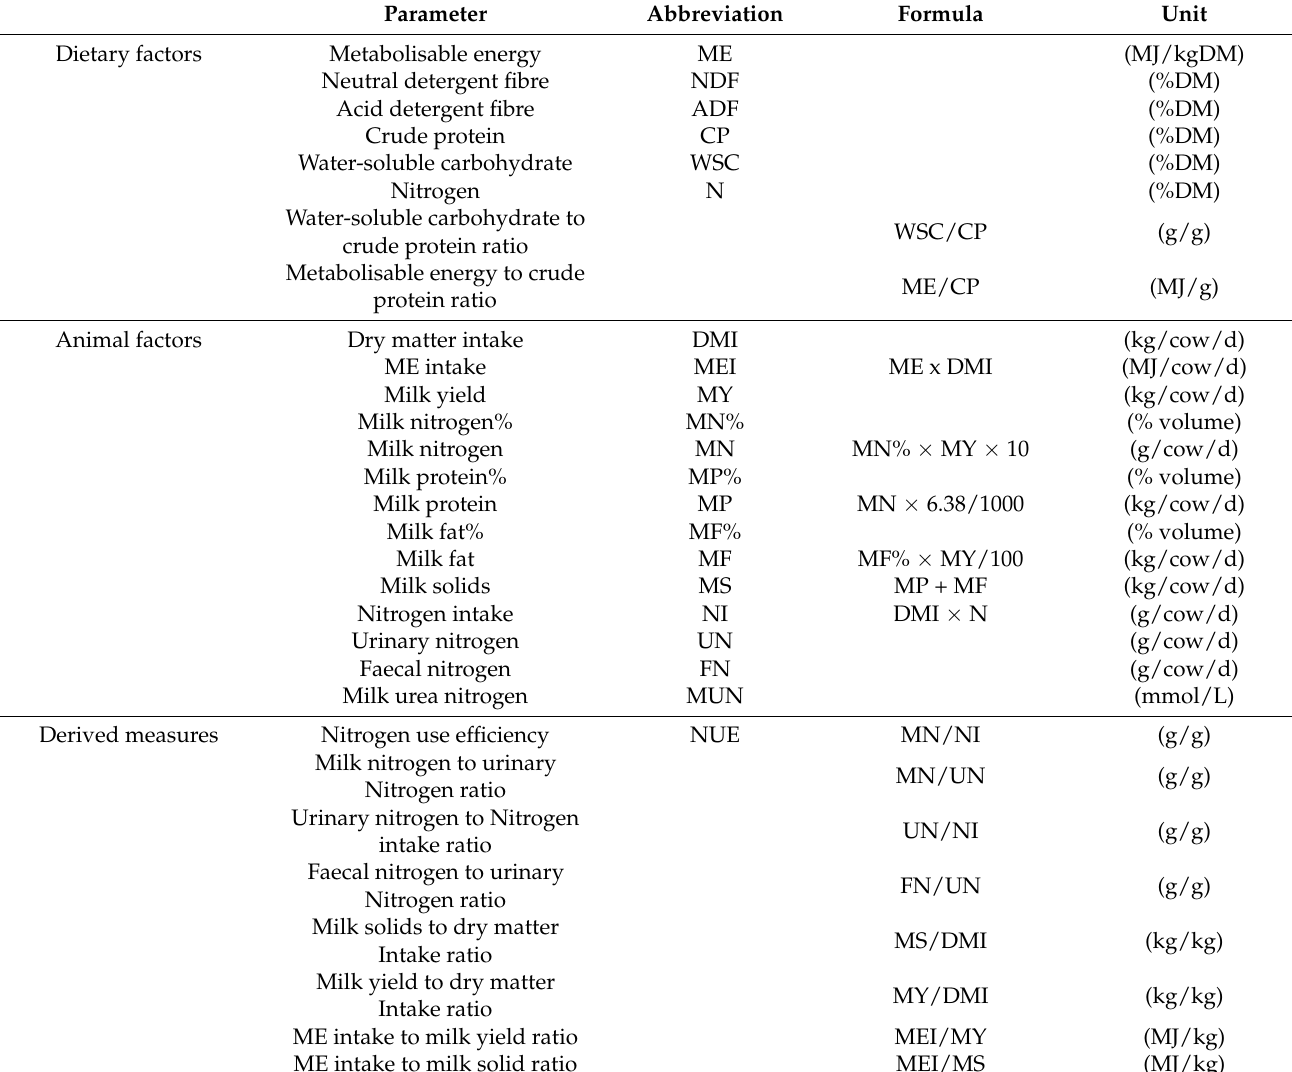
Table 2. Variables measured, units, abbreviations, and formulae for their calculation. If formulae have not been provided, variables were measured directly by chemical